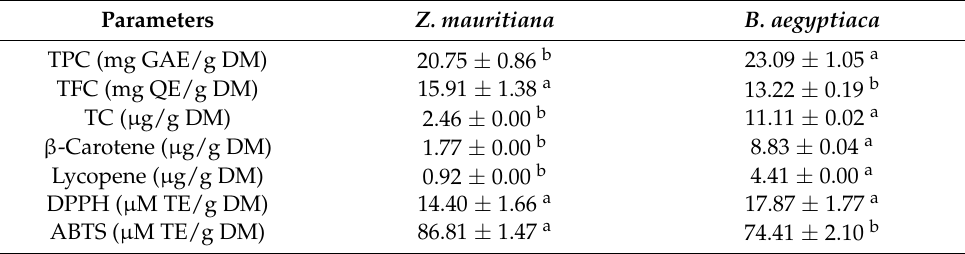
Table 5. Bioactive compound content and antioxidant power of microencapsulated Ziziphus mauritiana and Balanites aegyptiaca